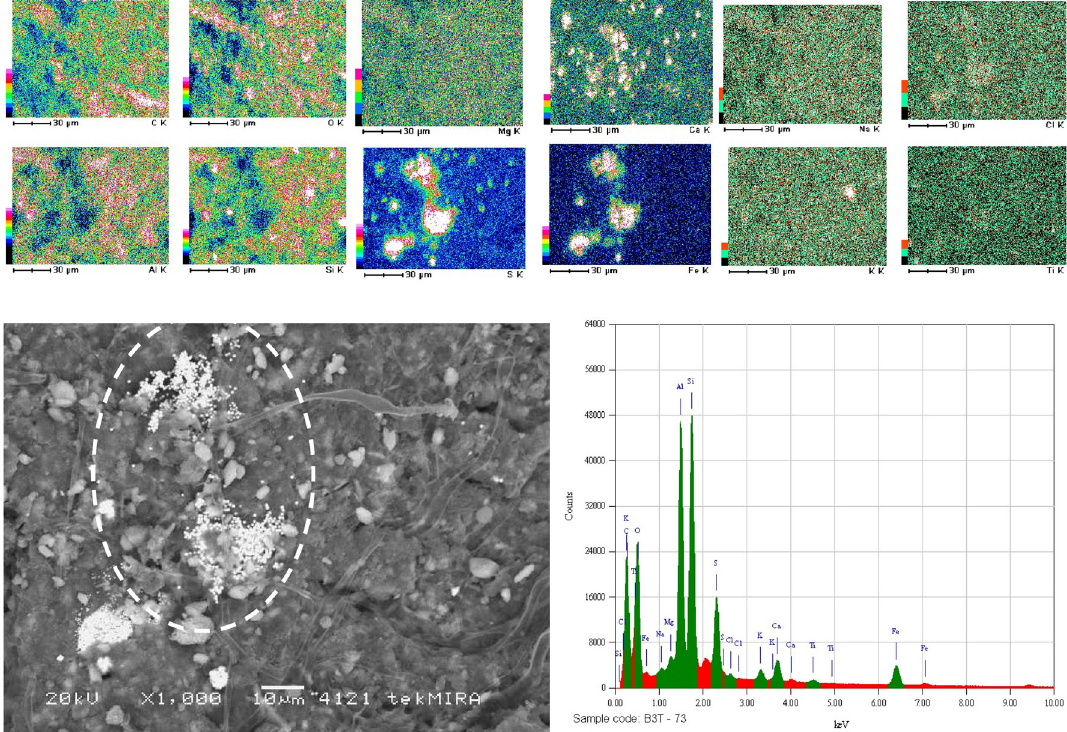
Fig. 7 Selected figure of SEM–EDS obtained from B3T-73 sample as an indication of the appearance of sulfur reducing